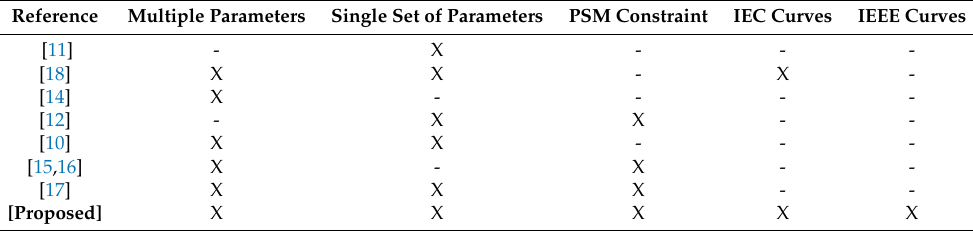
Table 1. Optimal coordination of OCRs in microgrids (knowledge